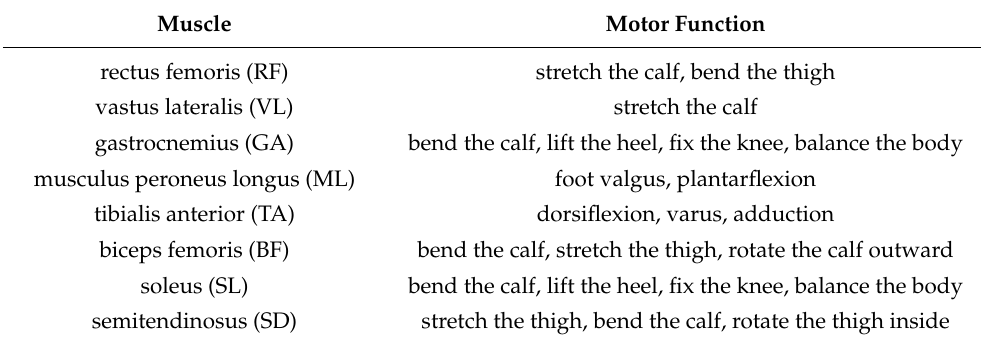
Table 1. Muscles and functions that play a major role in lower limb movement. Muscle Motor Function rectus femoris (RF) stretch the calf, bend the thigh vastus lateralis (VL) stretch the calf gastrocnemius (GA) bend the calf, lift the heel, fix the knee, balance the body musculus peroneus longus (ML) foot valgus, plantarflexion tibialis anterior (TA) dorsiflexion, varus, adduction biceps femoris (BF) bend the calf, stretch the thigh, rotate the calf outward soleus (SL) bend the calf, lift the heel, fix the knee, balance the body semitendinosus (SD) stretch the thigh, bend the calf, rotate the thigh